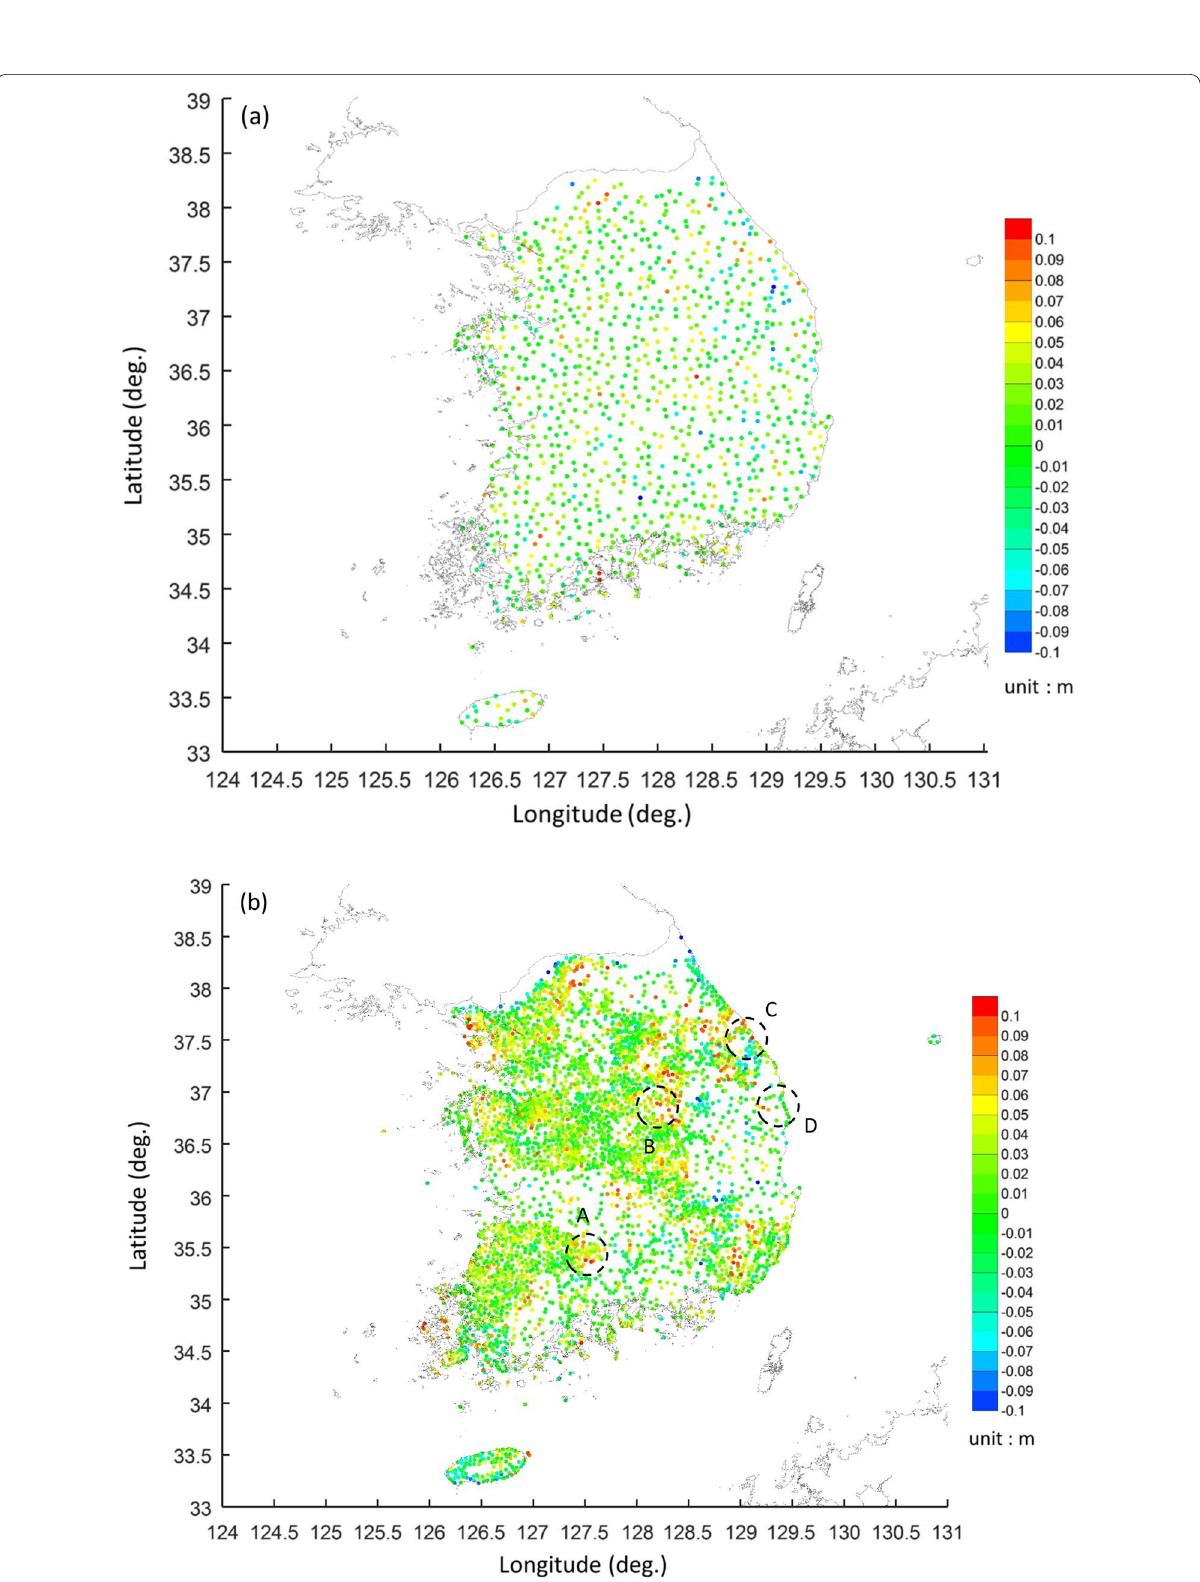
Fig. 9 Geoidal height differences between KNGeoid and GNSS/Leveling data: a KNGeoid18 and 1034 points of GNSS/Leveling data used for KNGeoid14 modeling, b KNGeoid14 and 4489 points of GNSS/Leveling data [re-plotted referring to Kwon et al.